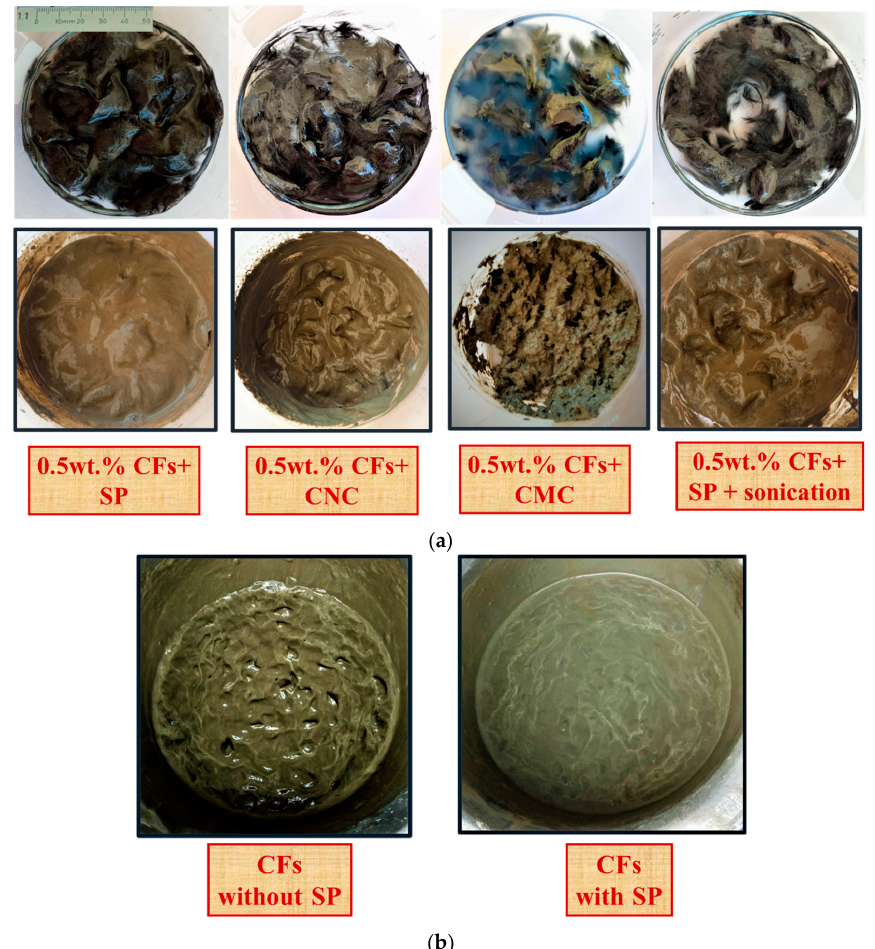
Figure 4. ( a ) Different wet dispersant and mixing methods of CFs and ( b ) dry mixing methods. The 7th, 14th, and 28th-day compressive strength of the carbon microfiber specimens with the different surfactants is depicted in the diagram in Figure 5. The addition of mi- crofibers resulted in an insignificant improvement in compressive strength for 0.5 wt.%, depending to a small extent on the carbon microfiber content. The 28-day, microfiber-re- inforced specimens showed the largest compressive strength enhancement, 10.4%, with the method of dry mixing without SP, while with the wet method of SP addition and sim- ple agitation with a manual stirrer by 8.6%. The method using the dry mixing method, adding SP, followed by 5%. The aforementioned mechanical performance exhibited by the 0.5 wt.% CF-reinforced composite may be attributed to the insufficient dispersion of carbon micro-fibers over the cementitious matrix. Figure 6 presents the flexural strength results of all mixtures at the hydration age of 28 days. Ι t is observed that most composite cement pastes show greater 28-day flexure strength in comparison to the reference material (plain cement specimen).